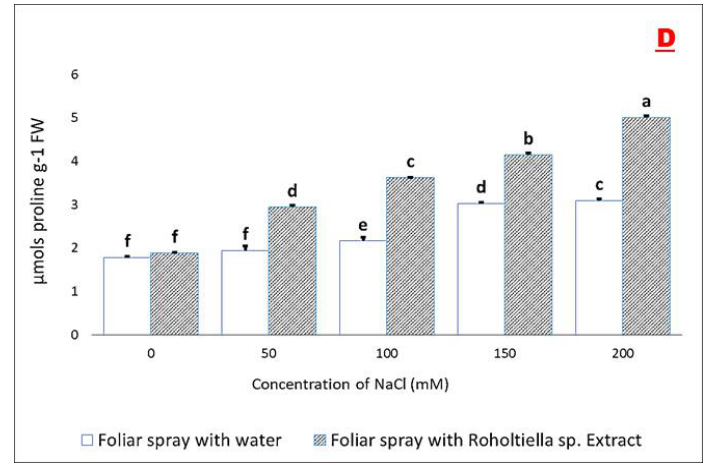
Figure 3. Effect of Roholtiella sp. extract on contents of chlorophyll-a ( A ), chlorophyll b ( B ), total chlorophyll ( C ), and proline ( D ) in bell pepper seedlings under salt stress. Bars accompanied with different letters indicate significant differences according to Turkey’s test at a significant level of 5% ( p < 0.05). Salinity concentrations are 0, 50, 100, 150, and 200 mM. The different letters (a–f) indicate significantly different values in response to the different treatments ( p < 0.05).